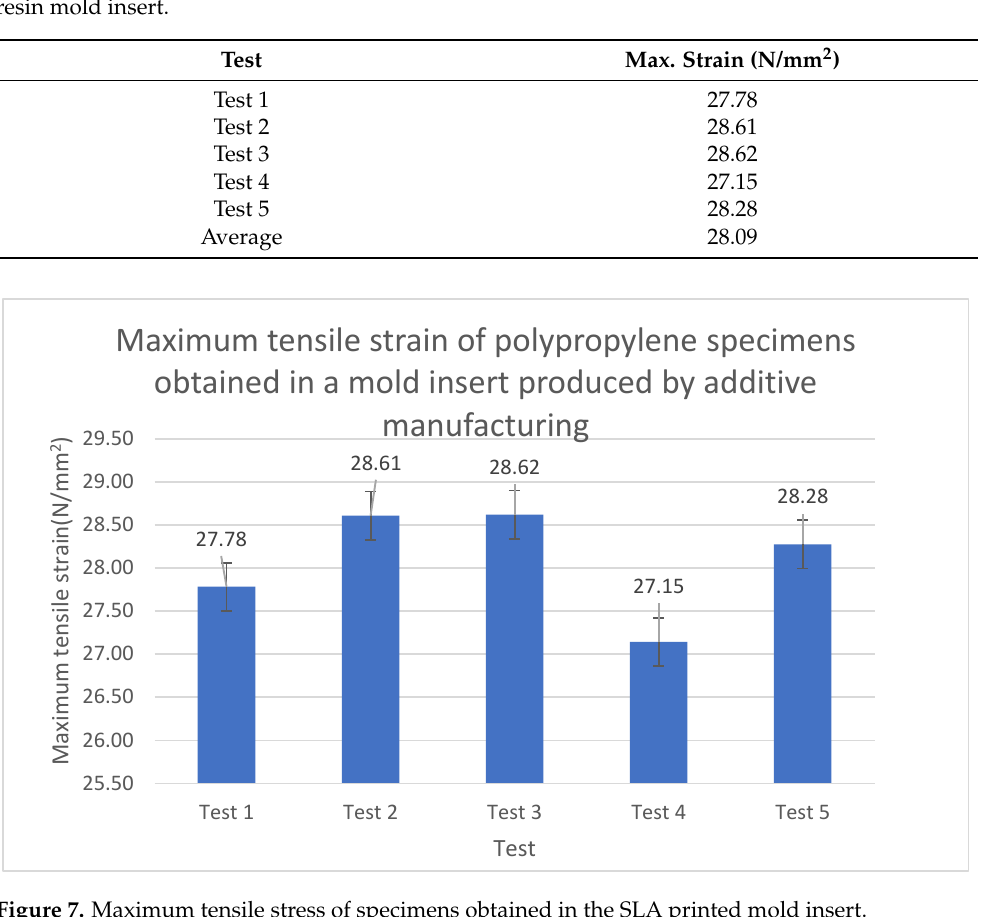
Figure 7. Maximum tensile stress of specimens obtained in the SLA printed mold insert.